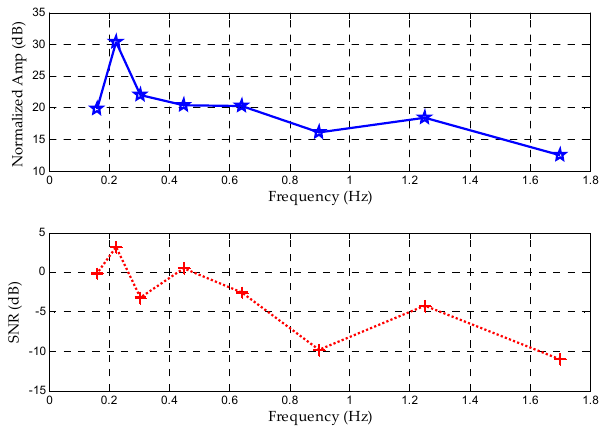
Figure 5. Normalized amplitudes and SNRs of different scales in terms of corresponding peak frequency based on prior knowledge.